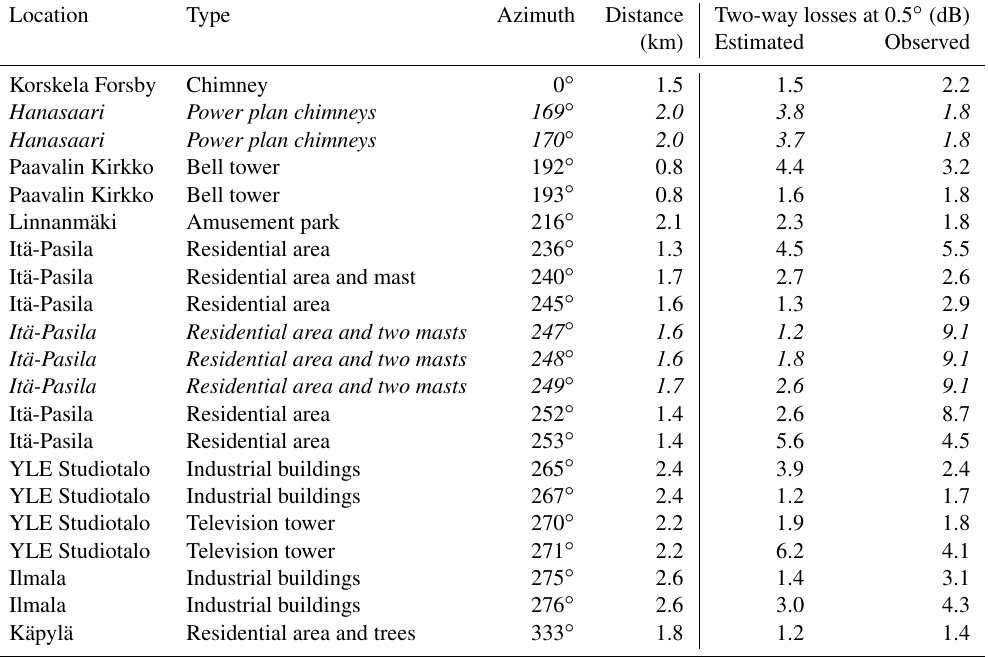
Table 3. Kumpula weather radar two-way losses at 0.5 ◦ elevation: comparison of estimated values from ALS data and observed ones derived by 24h accumulation rainfall. Italic-font rows report anomalies that are discussed in the